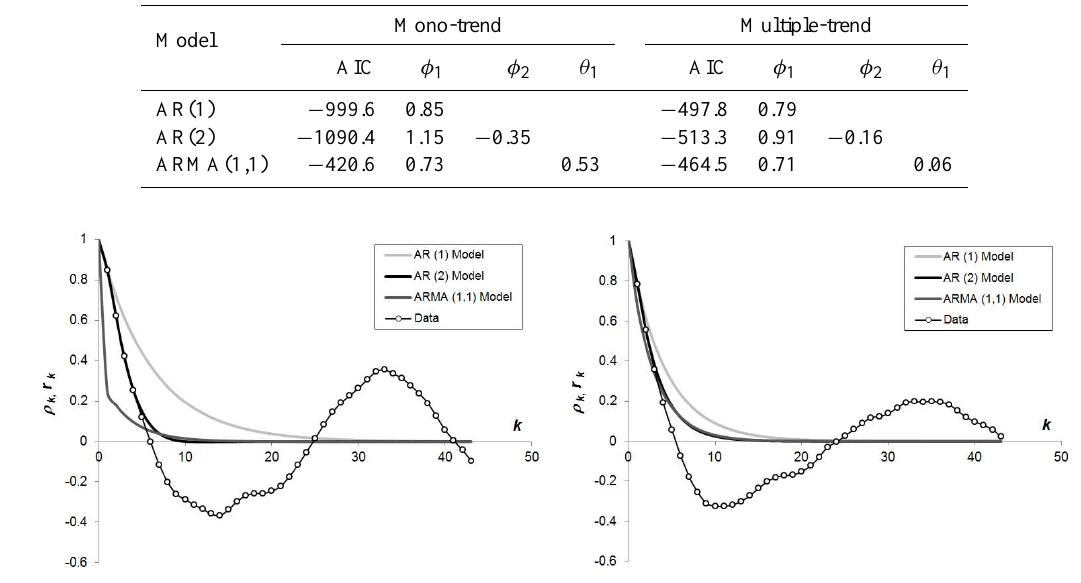
Fig. 5. Correlograms of (a) the mono- and (b) multiple-trend models.